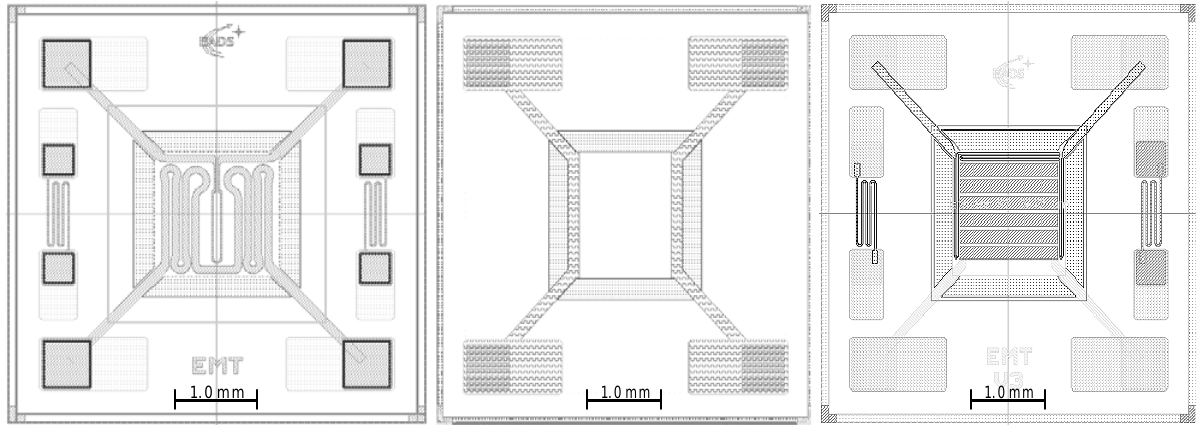
Figure 1. EM1 (left) mask layout of thermal IR emitter chips with on-chip temperature sensing and for assessing the long-term drift of the elements for controlling the membrane temperature T mem heater meanders [25]. EM2 (middle) is a design, which uses the thin, highly doped Si membrane in the middle as a bulk heater element with lateral Pt contact structures. EM3 (right) emitter design featuring an area heater based on SnO :Sb contacted by lateral Pt metallisations and additional on-chip 2 temperature sensing elements for controlling the membrane temperature T mem